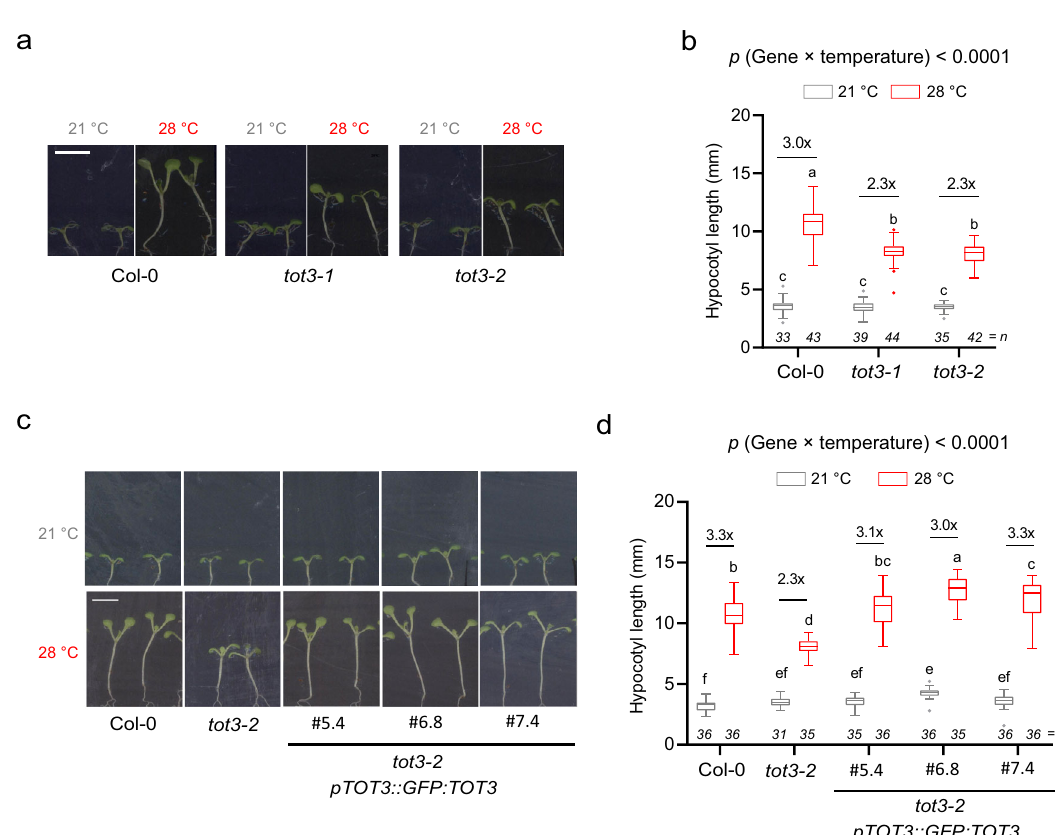
Fig. 2 TOT3 is required for thermomorphogenesis in Arabidopsis. a , b Hypocotyl length of 7-day-old Col-0 wild-type and loss-of-function tot3-1 , tot3-2 under short-day conditions at 21 and 28 °C (33 ≤ n ≤ 44). c , d Hypocotyl length of 7-day-old tot3-2 plants complemented with pTOT3::GFP:TOT3 (three independently transformed lines: #5.4, #6.8 and #7.4) under short-day conditions at 21 and 28 °C. Representative pictures ( a , c ) and hypocotyl length quanti fi cation ( b , d ). Scale bar, 5 mm. Box plots show median with Tukey-based whiskers and outliers. The number of individually measured seedlings ( n ) is indicated above the X -axis. Fold-change is indicated for each genotype. Letters indicate signi fi cant differences based on two-way ANOVA and Tukey ’ s test ( p < 0.01). The p -value for the interaction (genotype × temperature) is shown at the